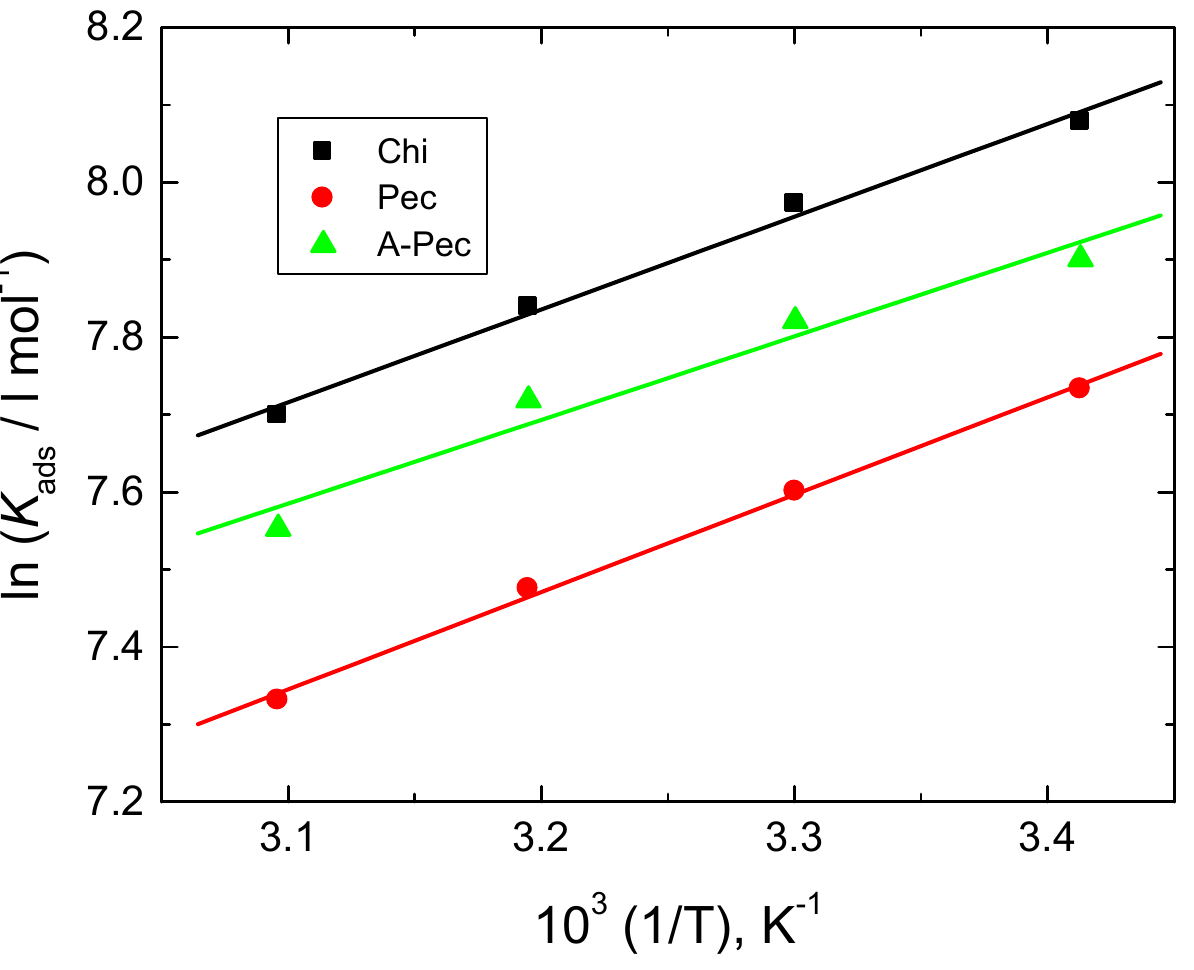
Figure 14. Van ‘t Hoff plots for the examined carbohydrate polymers: (a) Chi, (b) Pec, and (c) A-Pec adsorbed on mild-steel surface in 0.5 M HCl solution.